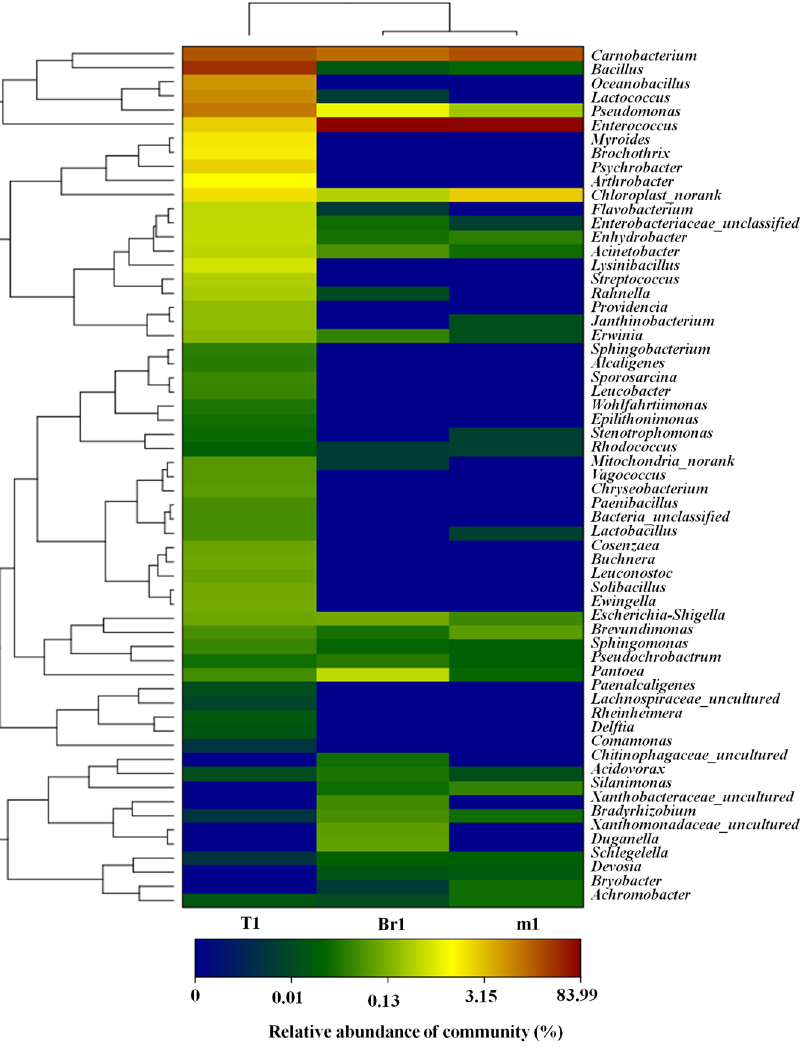
Figure 4. Bacterial distribution of the abundant genera in three samples. The bacterial phylogenetic tree was calculated using the neighbor-joining method. The heatmap plot depicts the relative abundance of each bacterial genus (variables clustering on the vertical axis) within each sample. The relative values for the bacterial genera are indicated by the color intensity with the legend in the top right